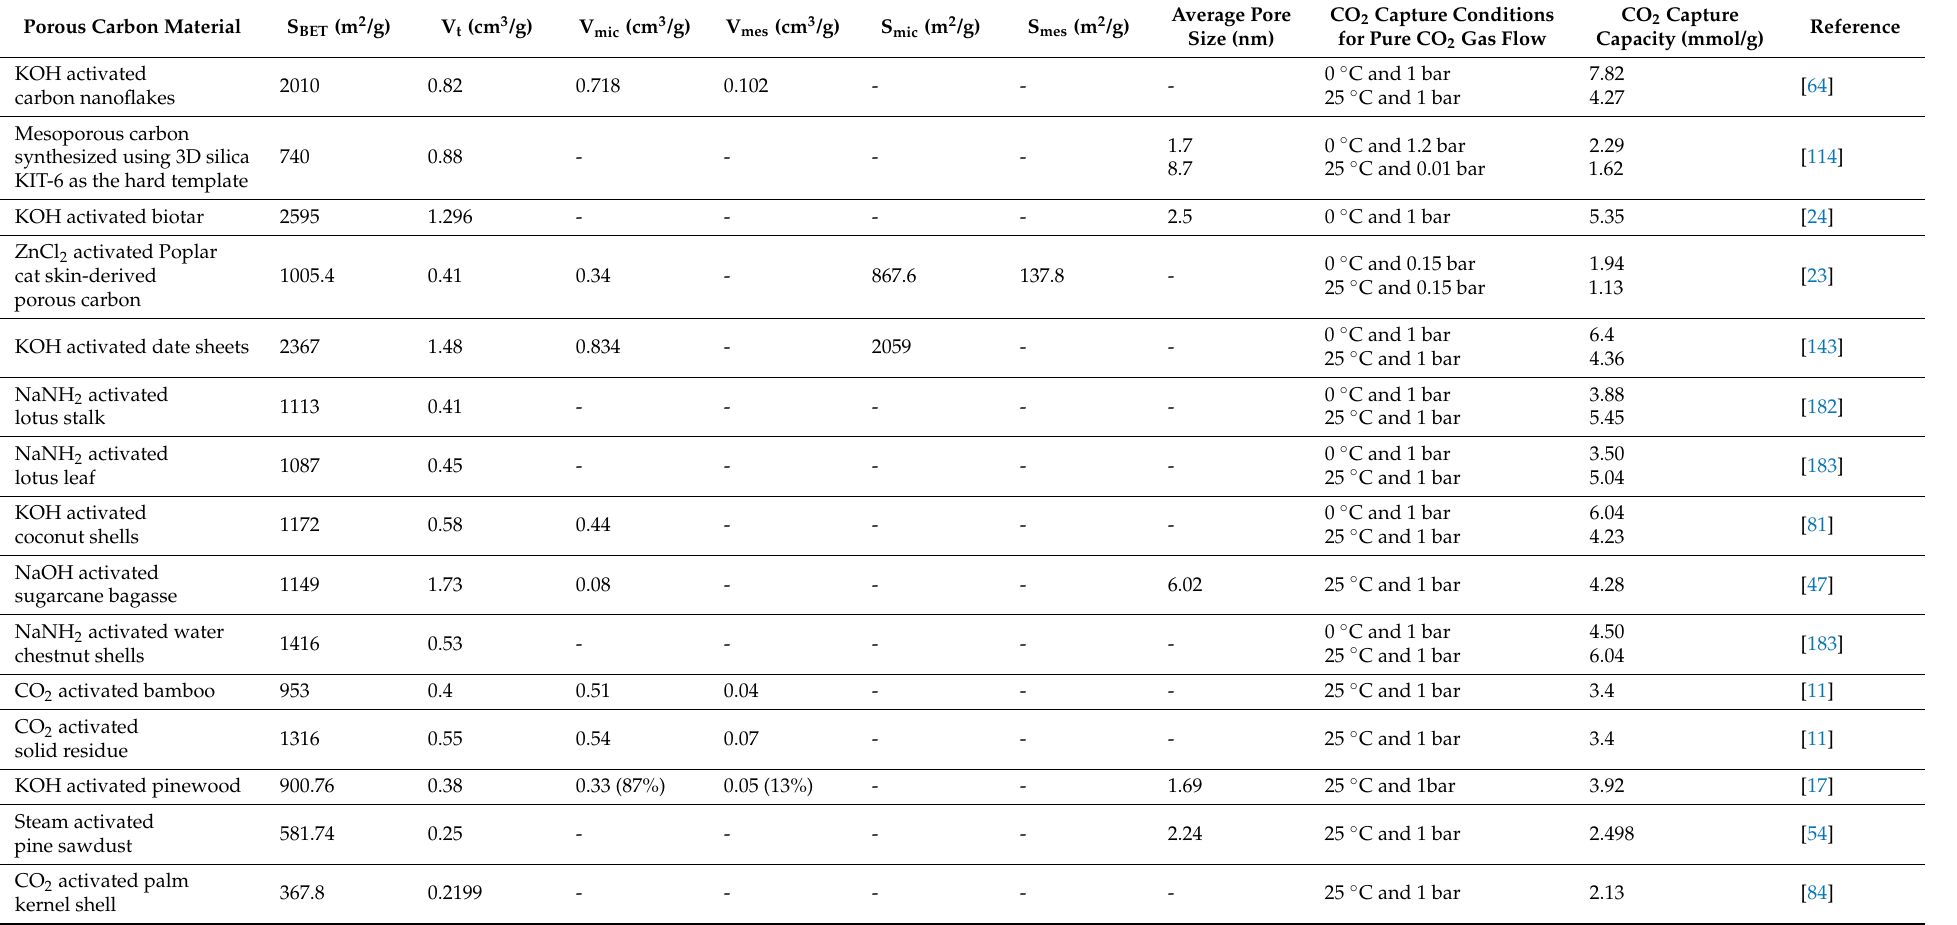
Table 8. Comparison of the CO 2 physisorption capacities of porous carbon